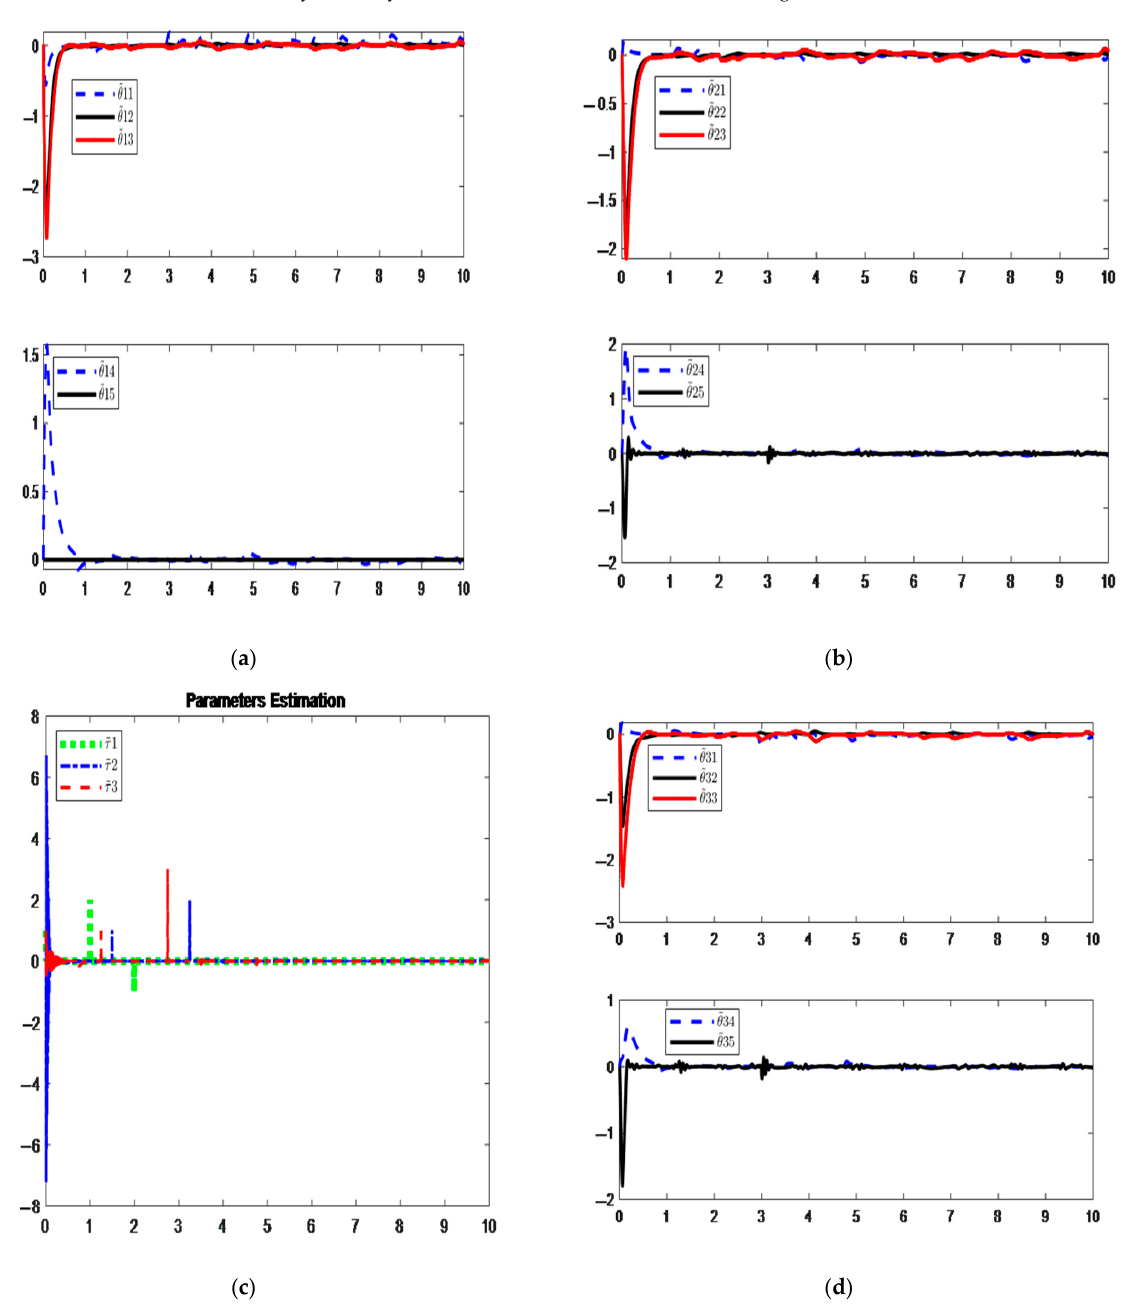
Figure 5. Estimation of parameters and time delay errors in multi-mode synchronization obtained during disturbance time delay and uncertainty. (( c ) indicates time delay errors and ( a , b , d ) indicate estimation of errors uncertainty)